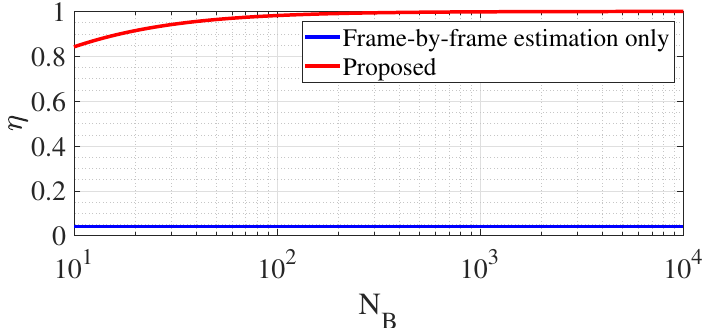
Figure 7. Efficiency for different lengths of data to be sent for the proposed scheme and the case with frame-by-frame estimation with quantized